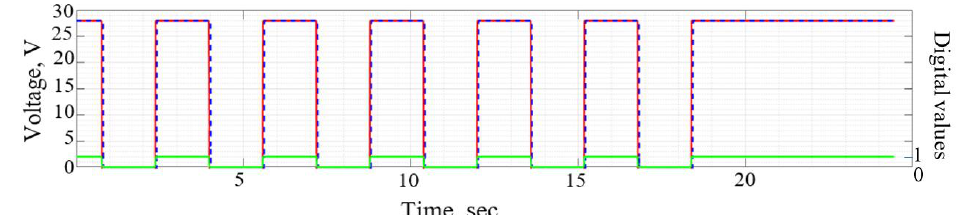
Figure 13. Test results: red graph — IPS readings according to the mathematical model; blue — real sensor readings; green — calculated numerical values of IPS readings (1 corresponds to high voltage, 0 is to low voltage), embedded in the mathematical model, determined by the geometry of the measuring bar and the speed of IPS sensors relative to the bar.